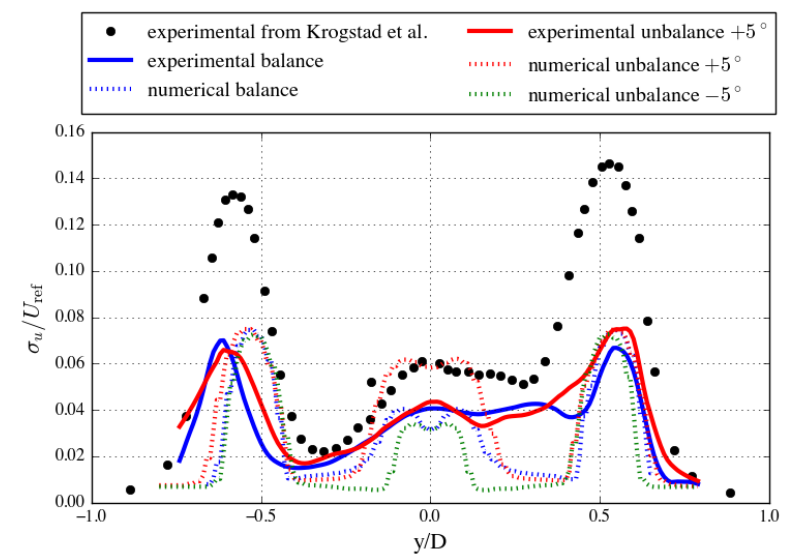
Figure 16. Numerical and experimental profiles of the normalised velocity standard deviation at hub height for the balanced and unbalanced cases at x / D = 3. See Figure 11 for the list of